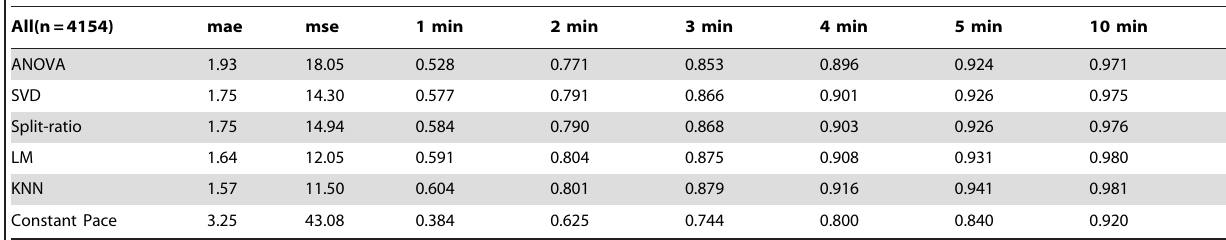
Table 2. All DNF in validation set.